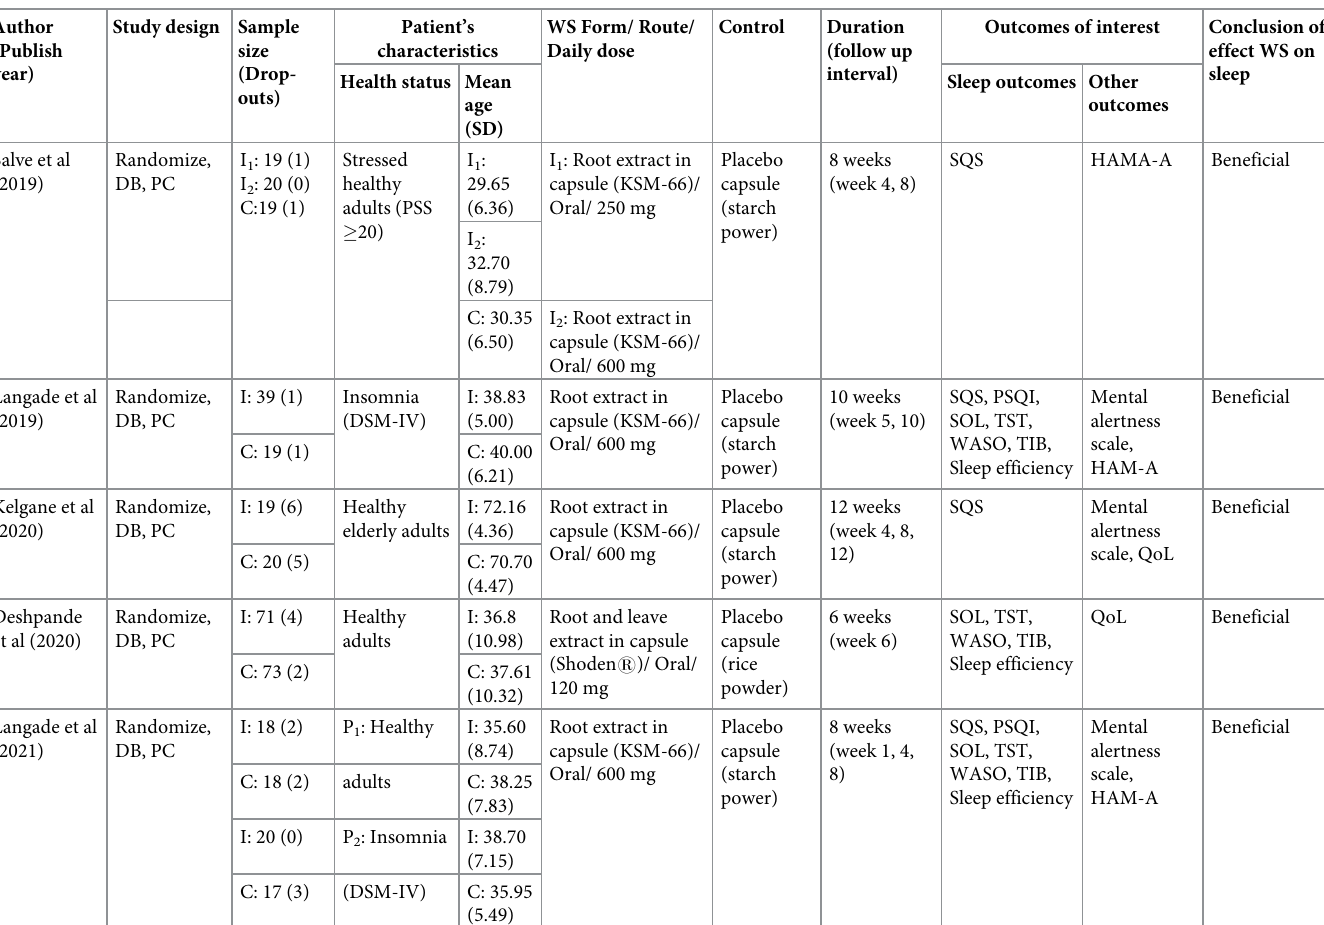
Table 1. Characteristic of included